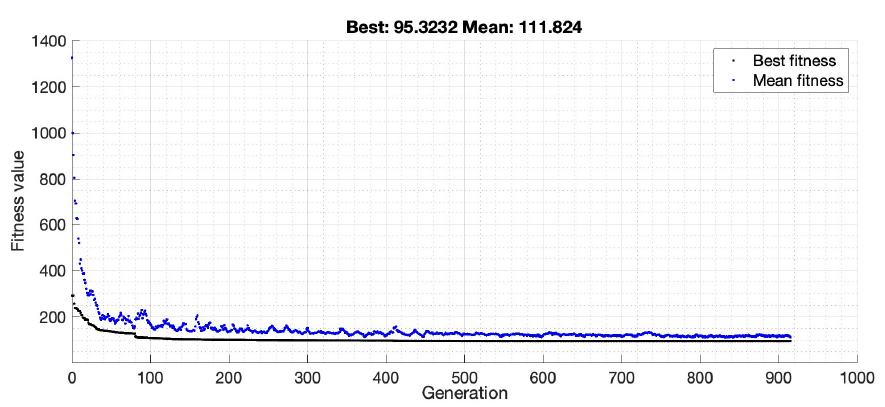
Figure 9 . GA convergence process . Table 3. DG cost parameters.